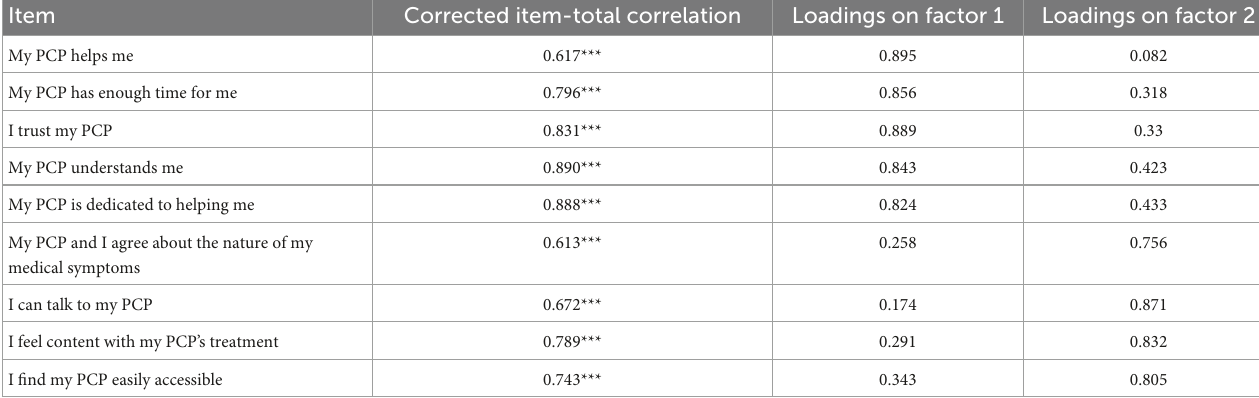
TABLE 2 Results of item analysis and factor